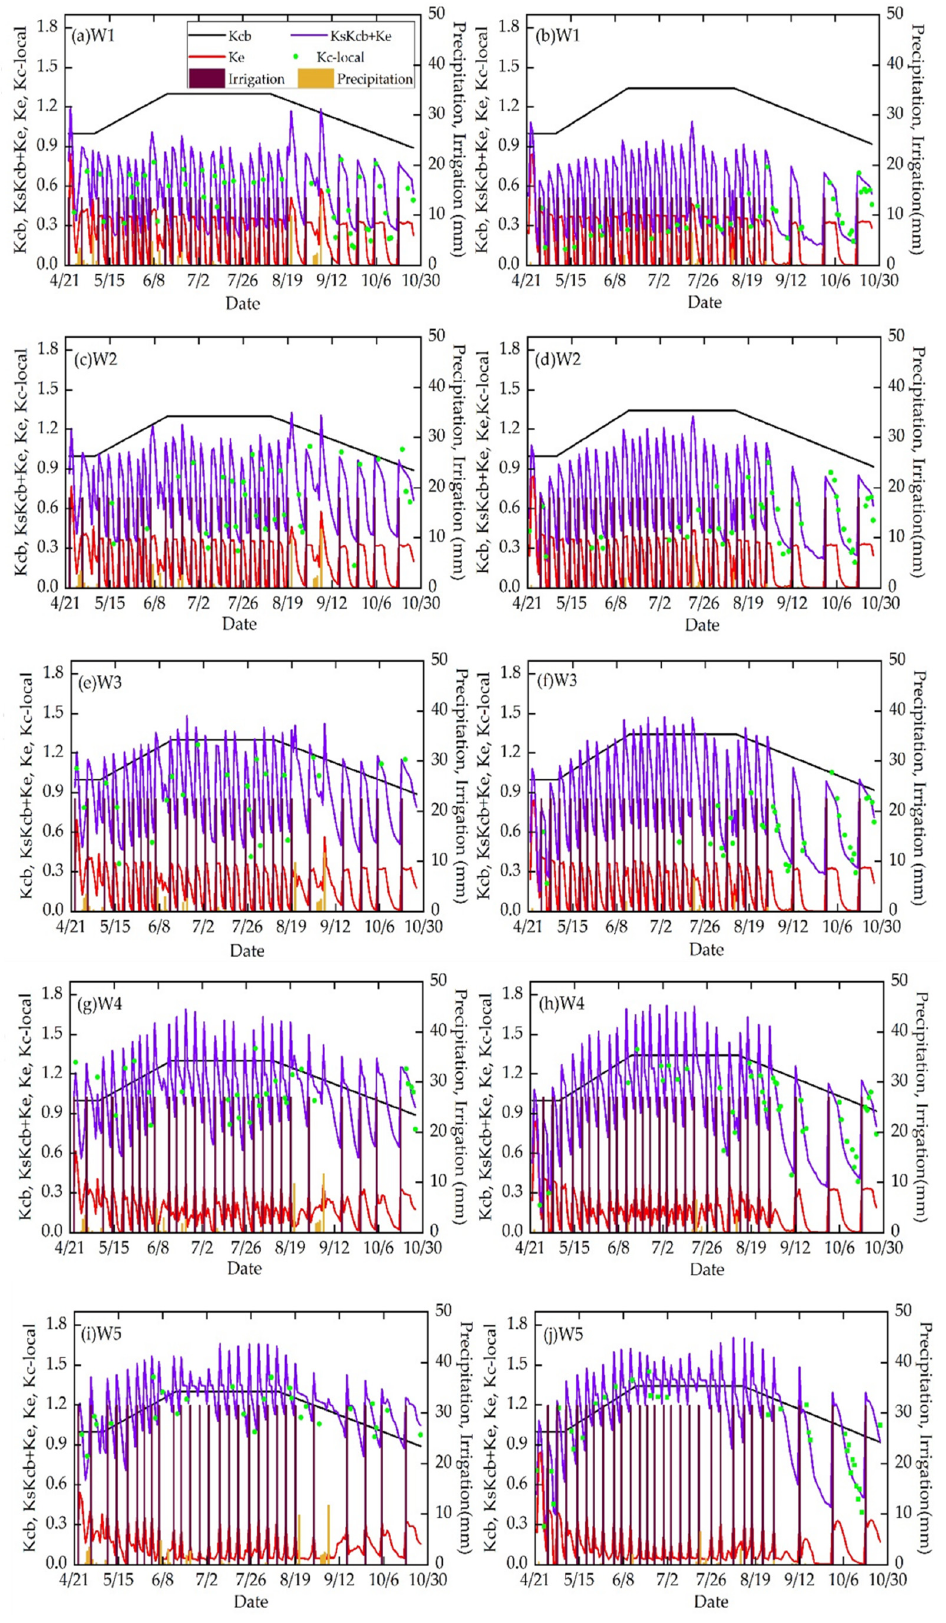
Figure 7. Variation of K cb , K s K cb + K e , K e , and K c-local of different treatments in 2019 (left column) and 2020 (right column).